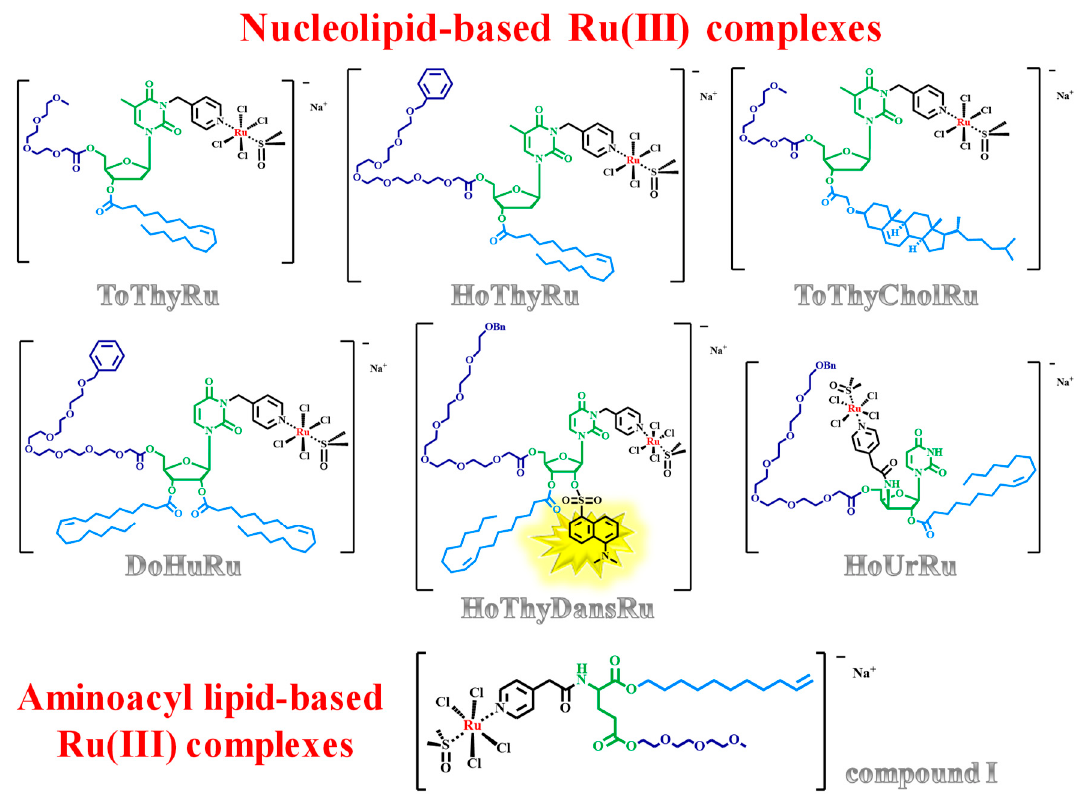
Figure 2. Chemical structures of the proposed nucleolipid and aminoacyl lipid-based Ru(III)-complexes. In the figures, ruthenium ions are indicated in red, the central scaffolds in green, while the hydrophilic and lipophilic chains in dark and light blue, respectively. In the HoThyDansRu molecular structure, the fluorescent dansyl group is highlighted in yellow (Bn = benzyl group).